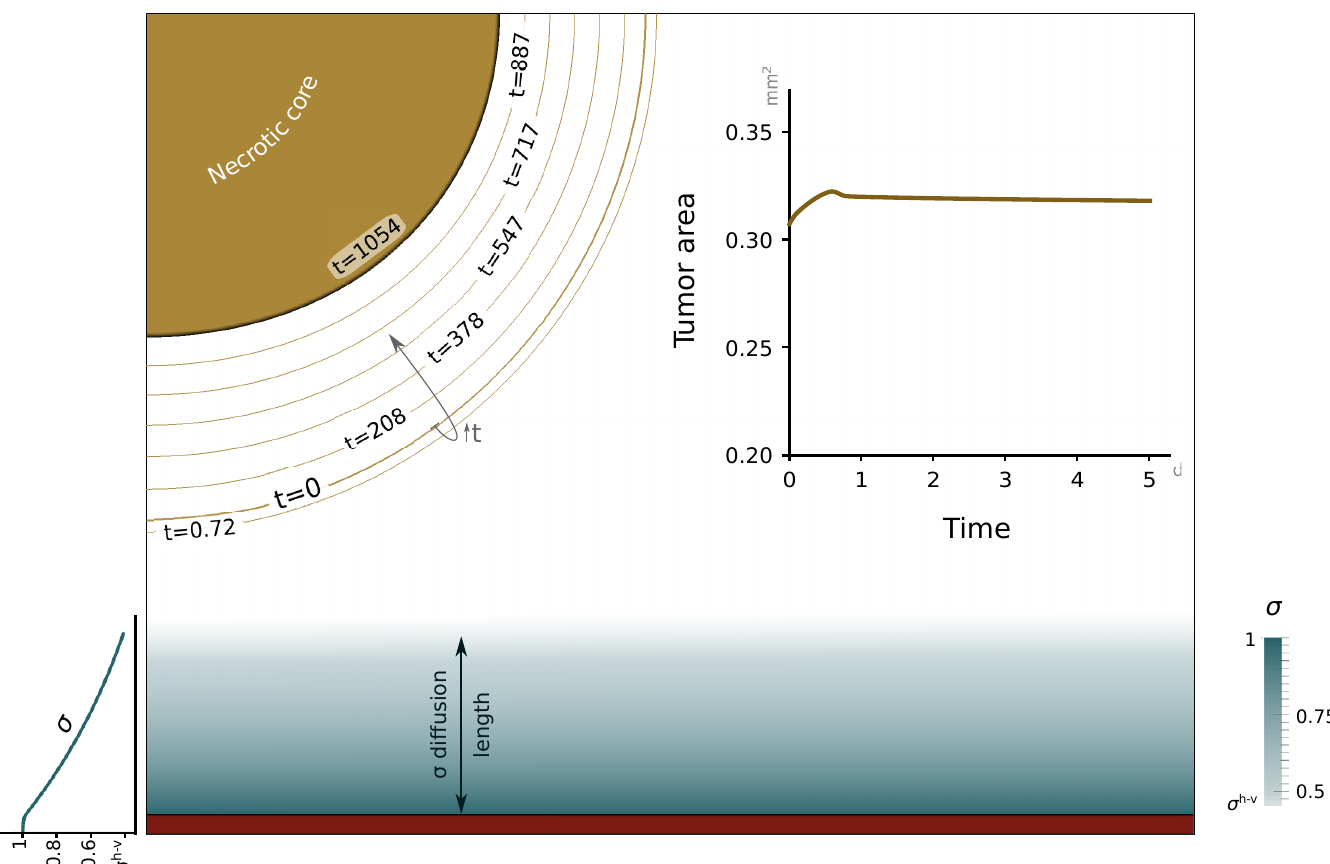
Fig 5. Simulation of avascular tumor growth. The amount of nutrient (blue scale) released from the capillary at the bottom edge is not enough for tumor cells to proliferate. Thus, the tumor remains at a constant size within usual experimental time scales (tumor area graph) and shrinks at very long time scales (brown contour lines). By day 1054 (solid brown), the tumor radius has been reduced to approximately 67% of its initial